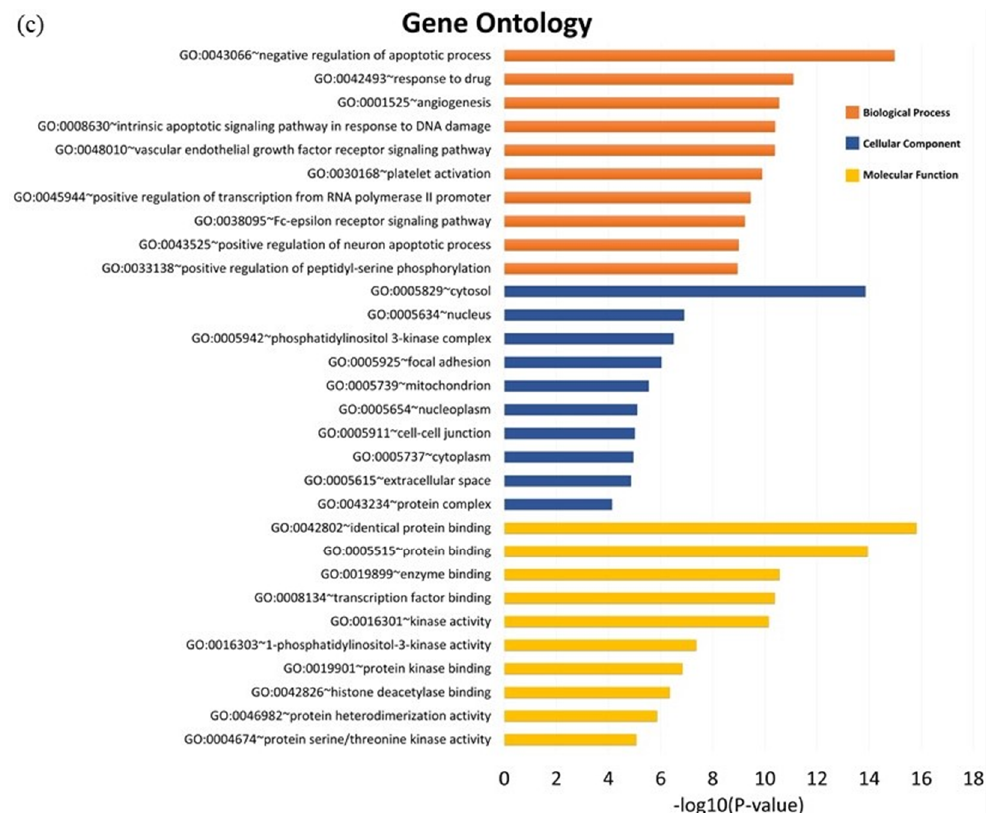
Figure 4. GO enrichment terms analysis of MO, and its combination with GEM against pancreatic cancer. ( a ) The bar chart represents the top 10 significant enrichment terms represented by the biological process, cellular component, and molecular function of MO + GEM intersection target genes against pancreatic cancer. ( b ) The bar chart represents the top 10 significant enrichment terms represented by the biological process, cellular component, and molecular function of shared biotargets intersection against pancreatic cancer. ( c ) The bar chart represents the top 10 significant enrichment terms represented by the biological process, cellular component, and molecular function of MO intersection target genes against pancreatic cancer.